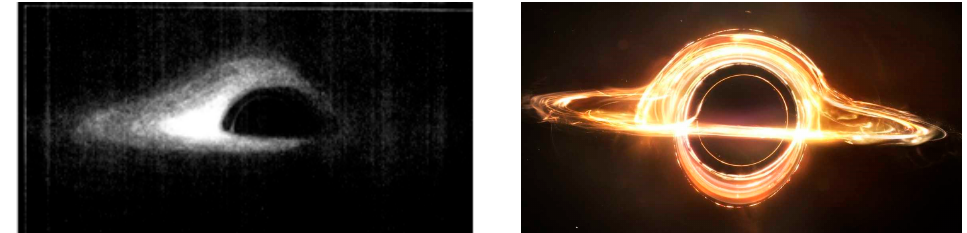
Figure 25. On the left, simulated photograph of a spherical black hole with a thin accretion disk, as seen by an observer 10° above the disk’s plane. Picture taken from [150]. On the right, in 2014, Christopher Nolan released the movie Interstellar and his science advisor Kip Thorne and colleagues used theoretical equations in order to approximate what a black hole could look like near maximal spin [151]. This asymmetry is due to two effects. The first effect results from the very strong gravitational lensing that enormously bends the trajectories of photons emitted from the accretion disk sector